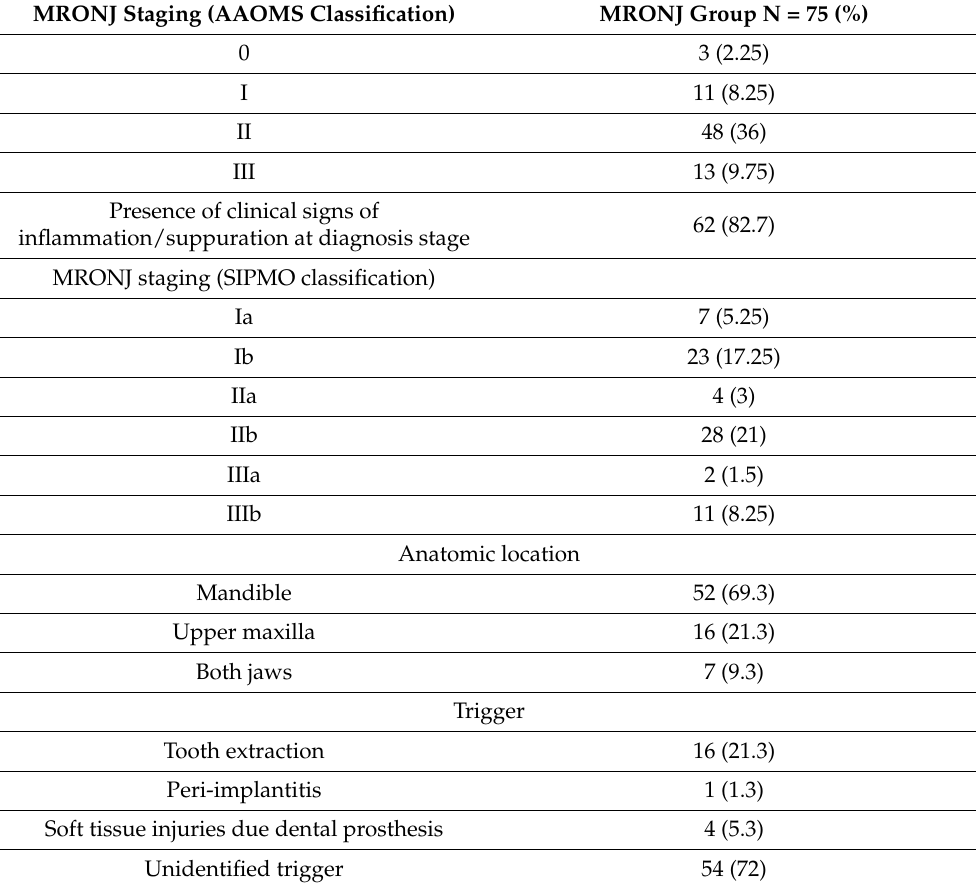
Table 2. Clinical characteristics of lesions in the MRONJ